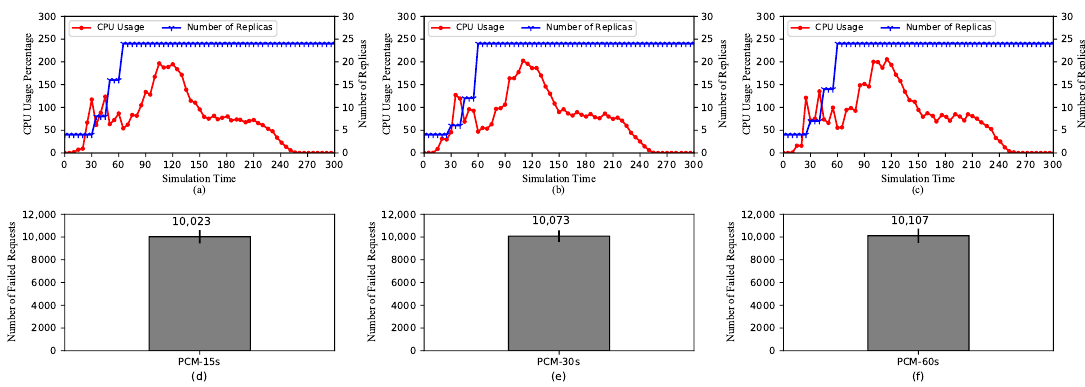
Figure 6. HPA using Prometheus Custom Metrics (PCM). ( a – c ) The average CPU usage and the scaling of the replica set for scraping periods of 15 s, 30 s, and 60 s, respectively. ( d – f ) The total number of the failed requests for scraping periods of 15 s, 30 s, and 60 s,